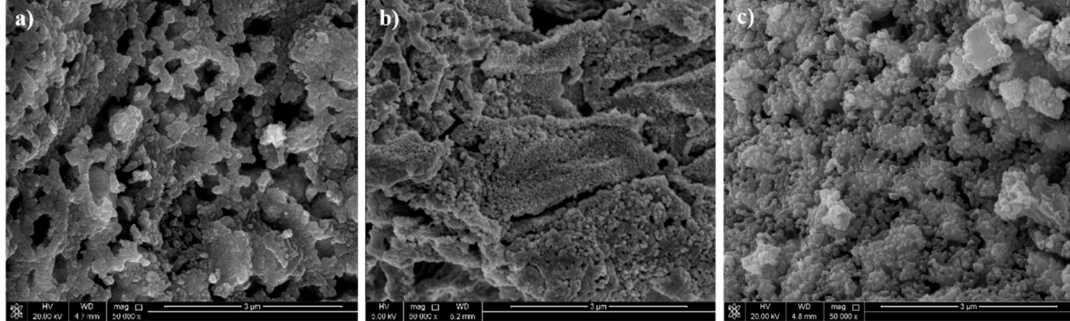
Figure 4. SEM of as-prepared Ag-Co alloys using different modes of SCS. ( a ) AgCo-11; ( b ) AgCo-12; and ( c ) AgCo-21.